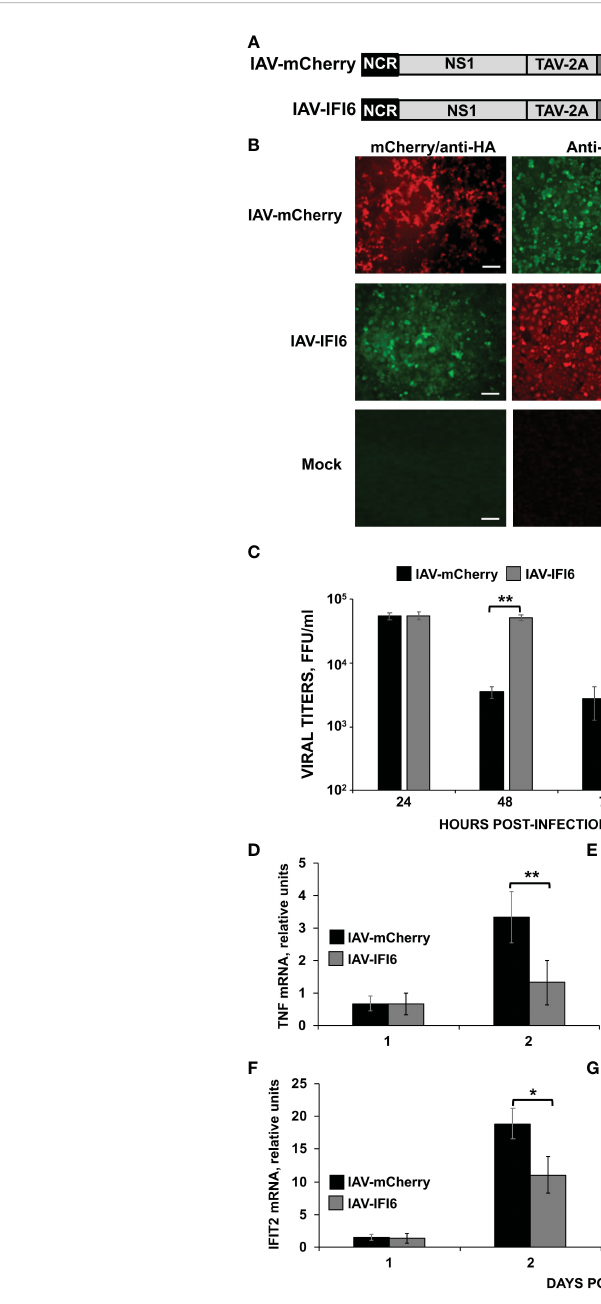
FIGURE 7 Effect of IFI6 expression on the induction of innate immune responses in vivo . (A) Schematic representation of PR8 viruses expressing mCherry and IFI6: A modi fi ed IAV-PR8 NS segment encoding NS1, mCherry (top) or IFI6-HA (bottom), and NEP are indicated. Black boxes at the beginning and end of each viral segment represent the viral 3 ’ and 5 ’ noncoding regions (NCR). White boxes indicate the viral NEP. Light gray boxes show the NS1 proteins. The thosea asigna virus (TAV) 2A 2A autoproteolytic cleavage site used for the expression of NS1 and mCherry/IFI6 and the porcine teschovirus (PTV) 2A autoproteolytic cleavage site used for the expression of mCherry/IFI6 and NEP are also indicated. (B) MDCK cells were non-infected (Mock) or infected (MOI 0.01) with IAV- mCherry and IAV-IFI6. At 24 hpi, cells were fi xed and permeabilized and visualized for mCherry expression. Then, the cells were stained with anti-HA and anti-NP Abs. DAPI was used for nuclear staining. Representative images (20× magni fi cation) are included. Scale bar, 50 m m. (C) A549 cells were infected with IAV-IFI6 and IAV-mCherry (MOI 0.1) and viral titers in the supernatants were measured by an immunofocus assay in MDCK cells. (D – G) Mice (n=4/group) were infected with IAV-mCherry and IAV-IFI6 viruses (2000 FFU/mice). At days 1 and 2 pi, TNF (D) , CCL2 (E) , IFIT2 (F) , and IFNL3 (G) expression was evaluated in mice lungs by RT-qPCR. Increases in mRNA levels were expressed as fold changes in comparison to mock-infected mice, used as controls. *P<0.05, **P<0.01 (using Student ’ s t